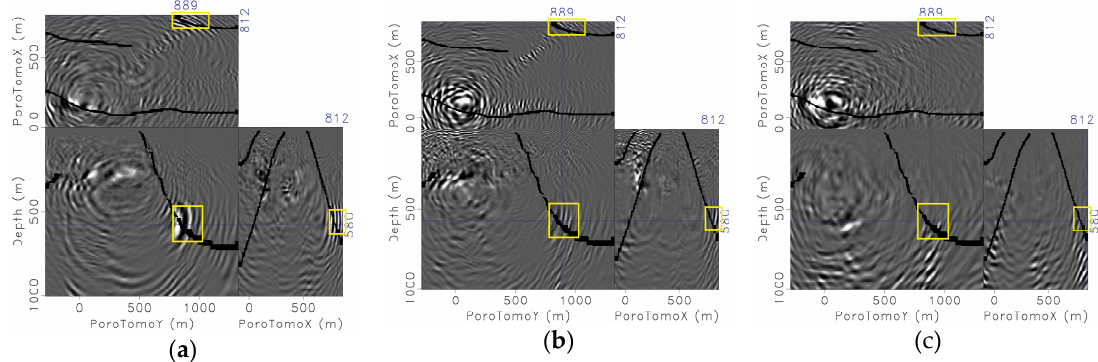
Figure 9. Far Eastern dipping fault. Kinematics: P-wave Velocity Down & S-wave Velocity Up (P–S image) of ( a ) Wr = synthetic 4 fault model, ( b ) Wr = Field Brady’s field data ( c ) Wr = Pure Noise.